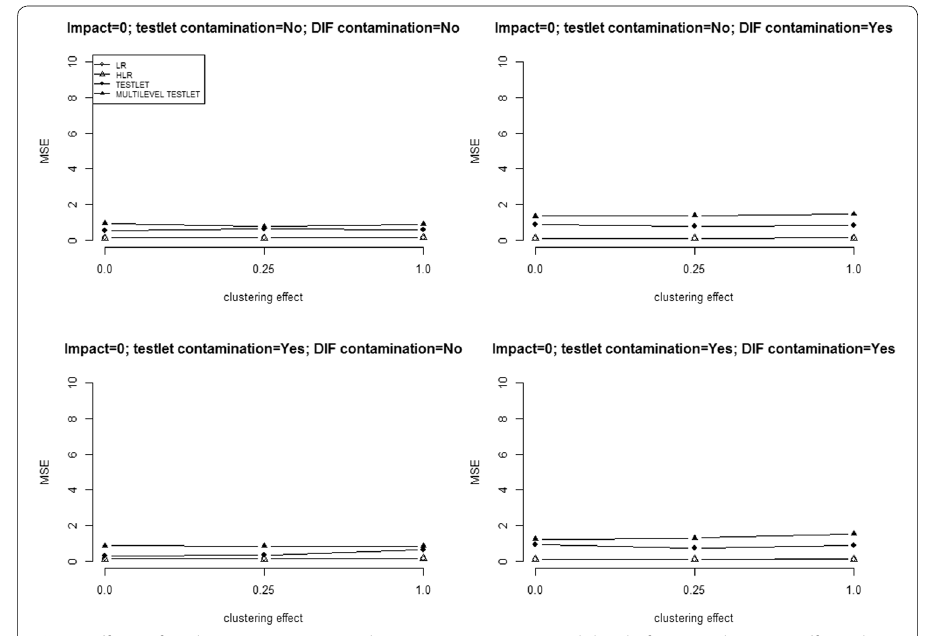
Fig. 6 Effects of testlet contamination and DIF contamination at each level of person clustering effect when there is no impact between groups